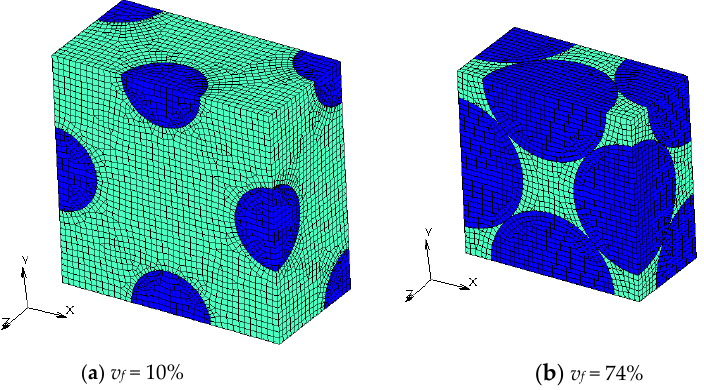
Figure 3. Transformation of Cartesian coordinates.